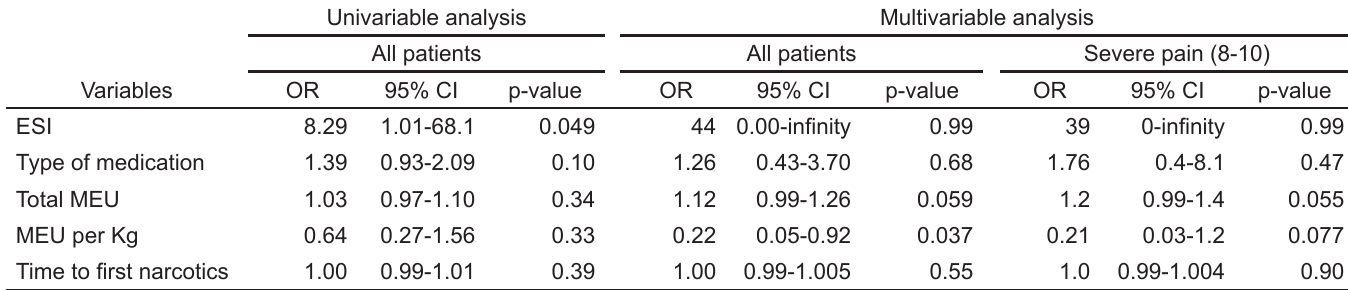
Table 2B. Results from multivariable logistic regressions assessing association between clinically-important factors and all patients or only pa- tients who presented with severe triage pain (pain level 8-10). Independent variables were first assessed for association with inadequate pain control at ED departure (Appendix). Variables with p-value<0.10 were included in the multivariable logistic regression in addition to other clinically significant factors (total MEU, MEU per Kg total body weight, time interval from triage to first administration of narcotics [time to first narcotics]).